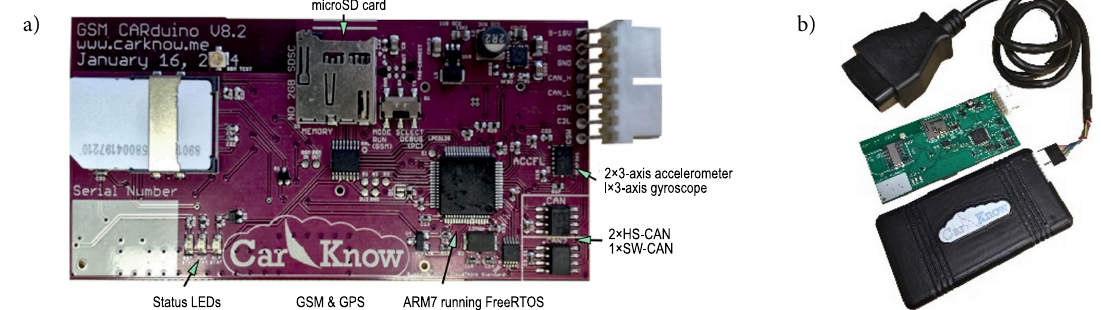
Fig. 2. CloudThink’s v8.2 low-cost, open-source CAR-duino for moving vehicle CAN/OBD-II data into the cloud (a) – each device has approximately these dimensions: 9.3×4.4×1.5 cm; connection and case of the